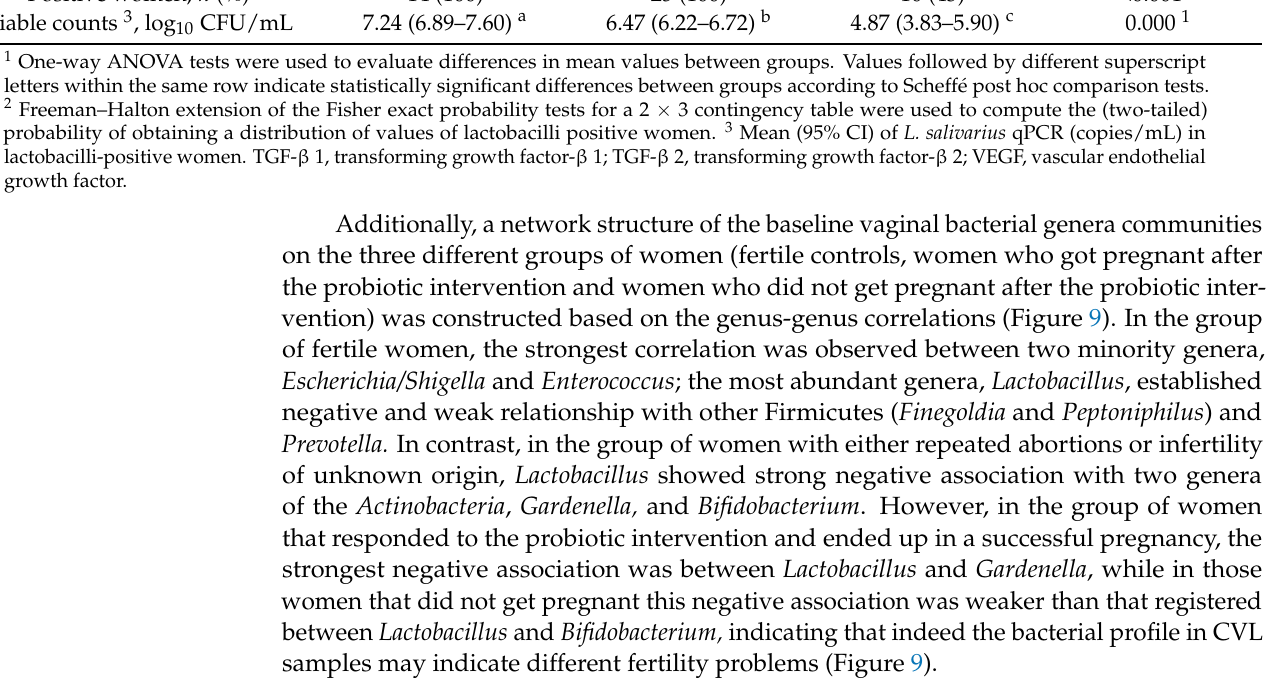
Table 7. Comparison of vaginal parameters (pH, Nugent score, TGF- β 1, TGF- β 2, and VEGF concentrations, and Lacto- bacillus counts) of all women who were able to complete a full-term pregnancy ( n = 25) and of those who did not ( n = 19) among all women with a history of repetitive abortion and with infertility of unknown origin (RA and INF groups) after the probiotic intervention with L. salivarius CECT5713 and vaginal parameters of fertile women (Control group; n = 14).